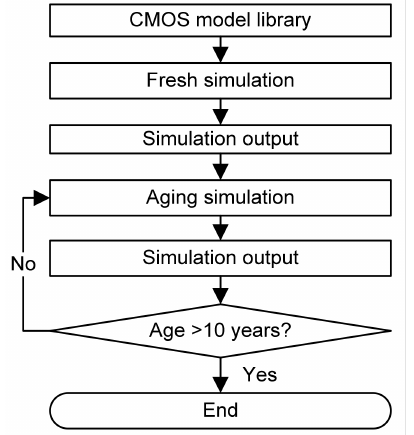
Figure 1. Simulation flow of the Eldo simulator for fresh and aging